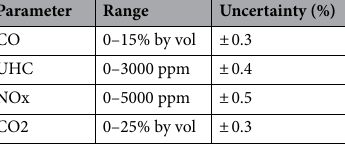
Table 5. Range of measuring parameters of emission gas analyser.